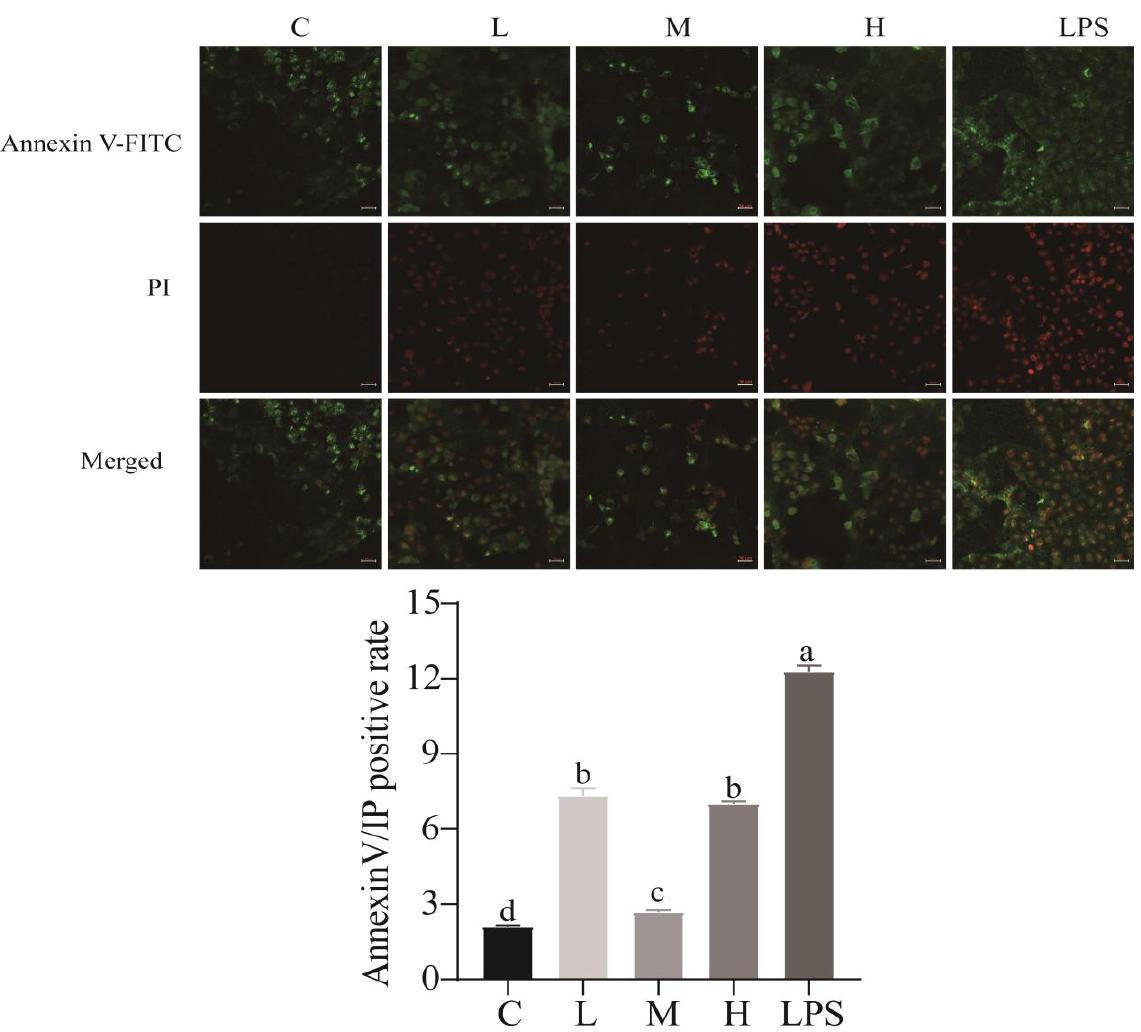
Figure 3. Effects of L. rhamnosus CY12 on the intracellular concentrations of apoptosis in LPS-induced Caco-2 Cells. Note: C represents uninduced Caco-2 cells; L, M, and H represent LPS-induced Caco-2 cells co-incubated with 10 7 , 10 8 , and 10 9 cfu/mL L. rhamnosus CY12, respectively; LPS represents LPS-induced Caco-2 cells. Means with the different letters (annexin V/IP positive rate) are significantly different p < 0.05. The magnification of these picture is 100X, and scale bar is 50 µm. The early apoptotic cells showed green fluorescent light under the microscope. The late apoptotic cells showed red and green fluorescent light under the microscope, and normal cells displayed no fluorescence.